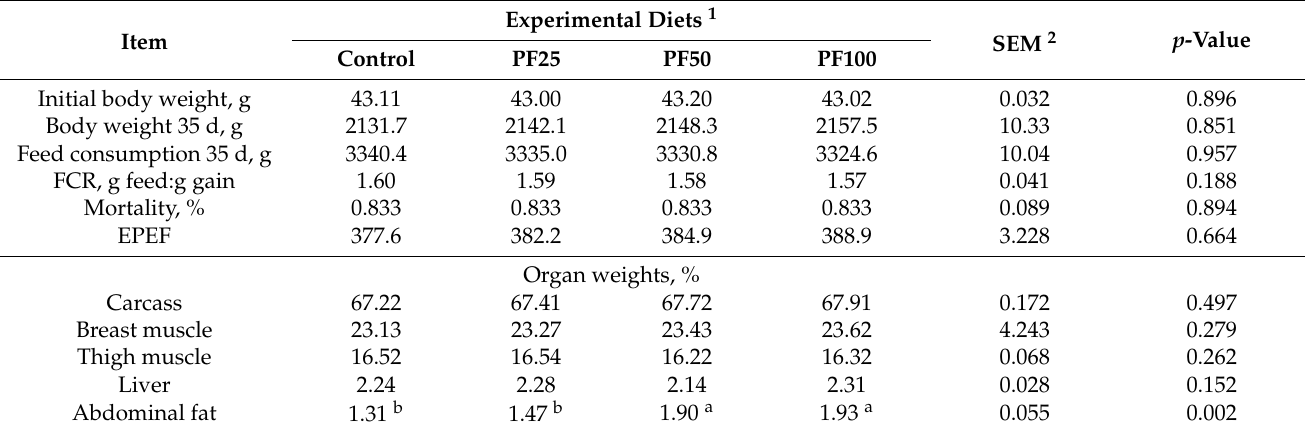
Table 3. Effect of replacing soybean oil with poultry fat on growth performance and organ weights of broilers.